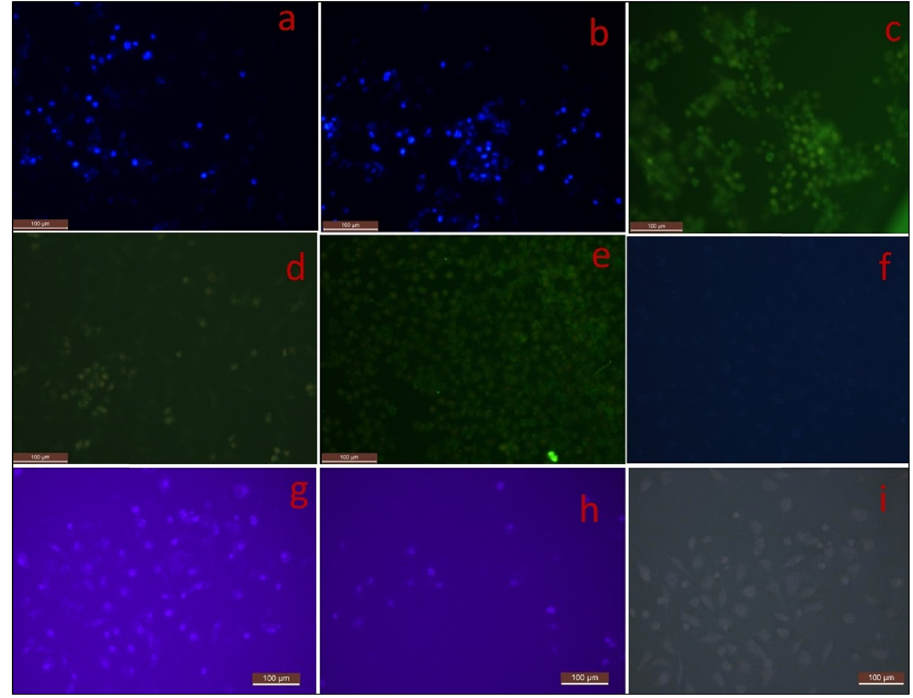
Figure 8: Fluorescence inverted microscopy image of Caco - 2, extract, and DAPI ( a ) , Caco - 2, AgNPs@Org, and DAPI ( b ) , Caco - 2 and control ( c ) , L929, extract, and FITC ( d ) , L929, AgNPs@Org, and FITC ( e ) , L929 and control ( f ) , Capan - 1, extract, and DAPI ( g ) , Capan - 1, AgNPs@Org, and DAPI ( h ) , and Capan - 1 and control ( i ) . DAPI images and FITC images showed apoptotic cells and the necrotic cells,